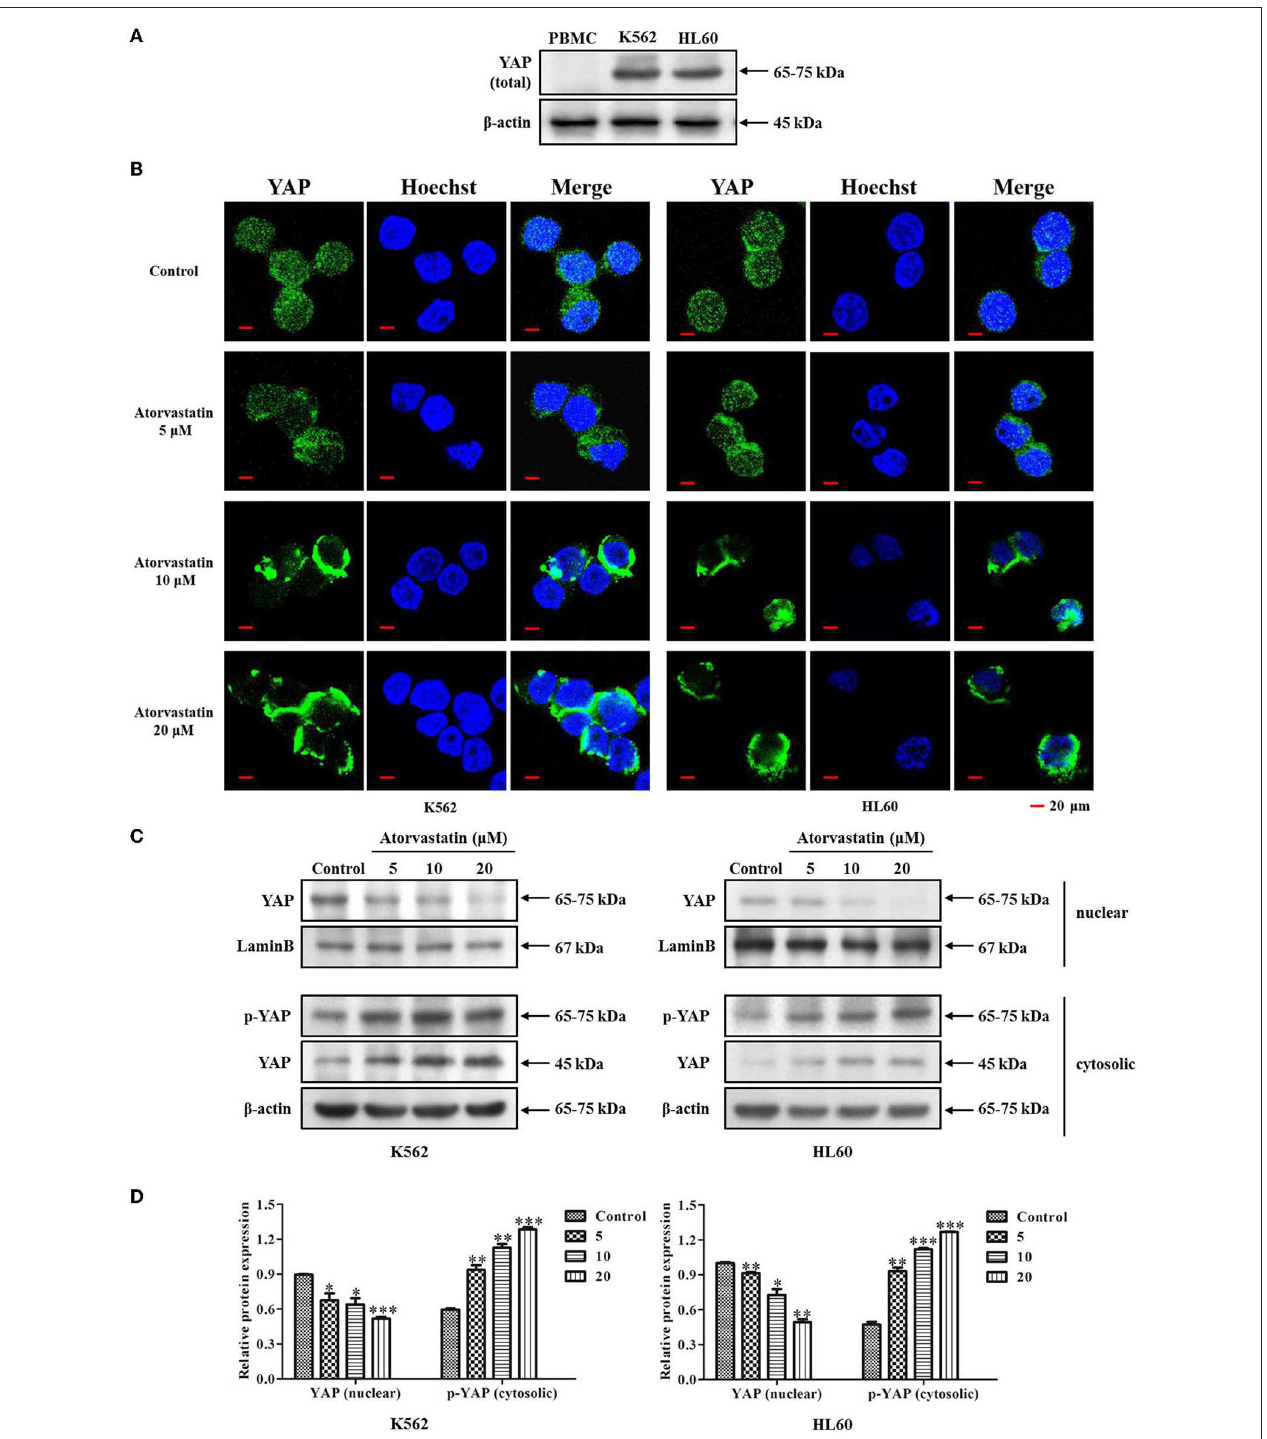
FIGURE 6 | Atorvastatin inhibits YAP nuclear localization in K562 and HL60 cells. (A) The expression of YAP in leukemia cell lines (K562 and HL60) and PBMCs from healthy volunteers ( n = 3) was determined by western blot analysis. (B) K562 and HL60 cells were incubated with Atorvastatin (0, 5, 10, and 20 µ M) for 48h. The subcellular localization of YAP was examined by immunofluorescence and visualized under Olympus laser scanning confocal microscope. The nuclei were counterstained with Hoechst. The representative images were shown. Scale bar, 20 µ m. (C) The levels of YAP in nucleus and p-YAP (Ser127) in cytoplasm were determined by western blot. (D) Bar graphs show the relative levels of YAP and p-YAP (Ser127). Data are presented as mean ± SD of three independent experiments. * p < 0.05, ** p < 0.01, *** p < 0.001 vs. control.